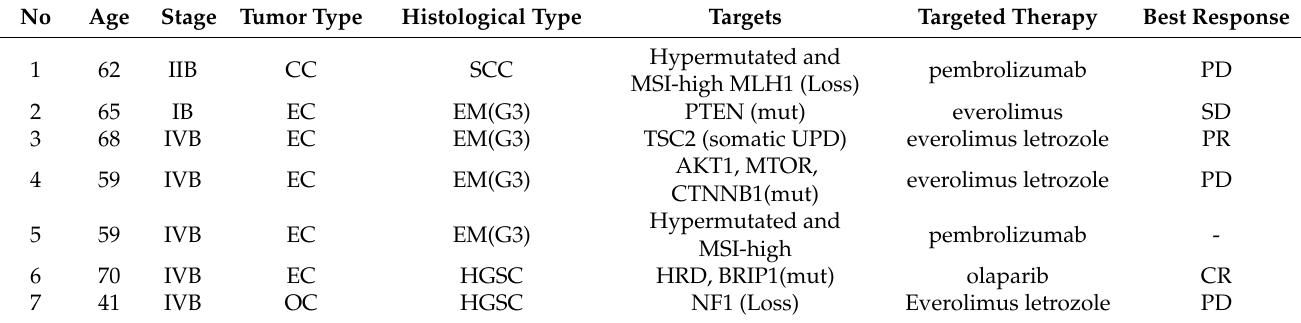
Table 2. Summary of patients who received genotype-matched